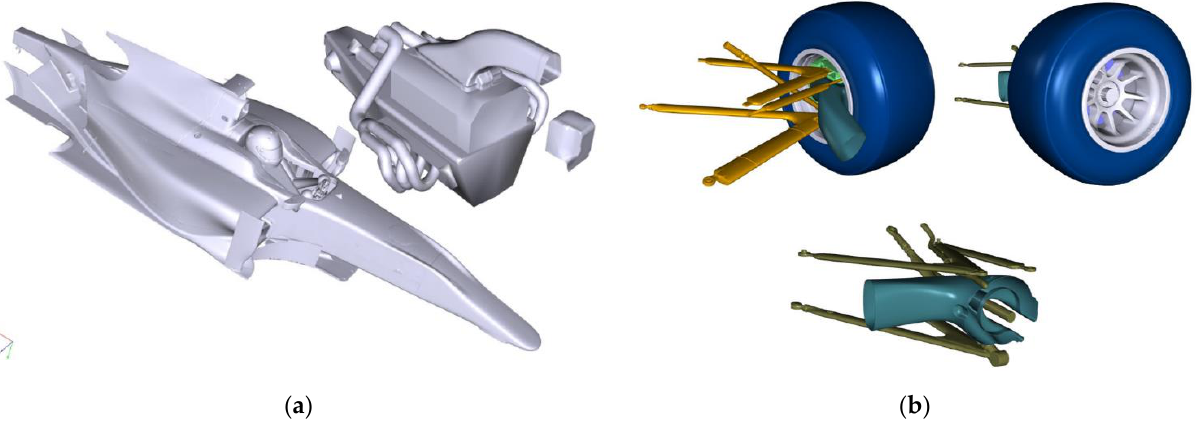
Figure 1. Vehicle 3D scans: ( a ) Scan of main vehicle body and engine-gearbox unit; ( b ) Scan of suspension and wheel assemblies with fully detailed brake cooling ducts.